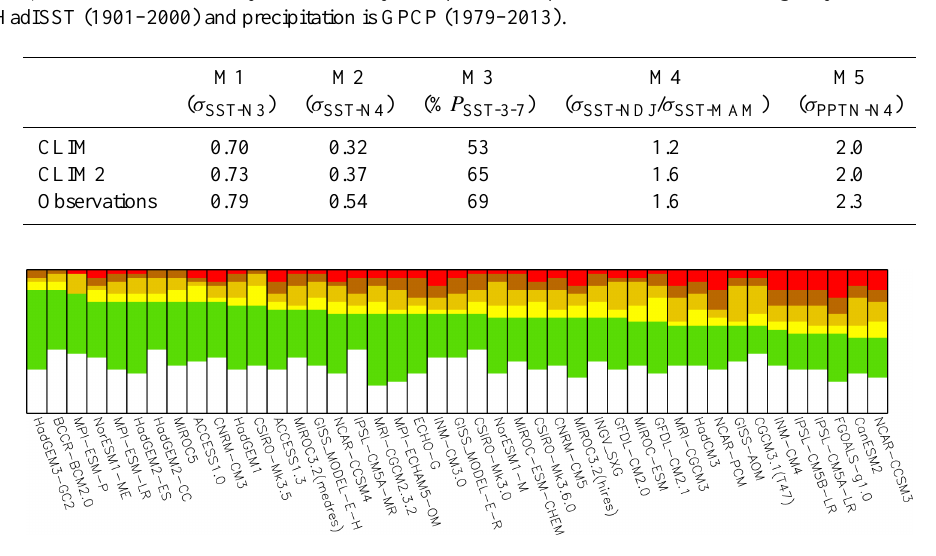
Table 3. Metrics for ENSO assessment. M1 and M2 are standard deviation of monthly SST anomaly for regions Niño3 (90–150 ◦ W, 5 ◦ N– 5 ◦ S) and Niño4 (160 ◦ E–150 ◦ W, 5 ◦ N–5 ◦ S) (K), M3 is the ratio of power in the 3–7 year range relative to 0 to 10 years for monthly Niño3 SST anomaly (%), M4 is a seasonality metric defined as the ratio of November to January and March to May standard deviation of Niño3 SST